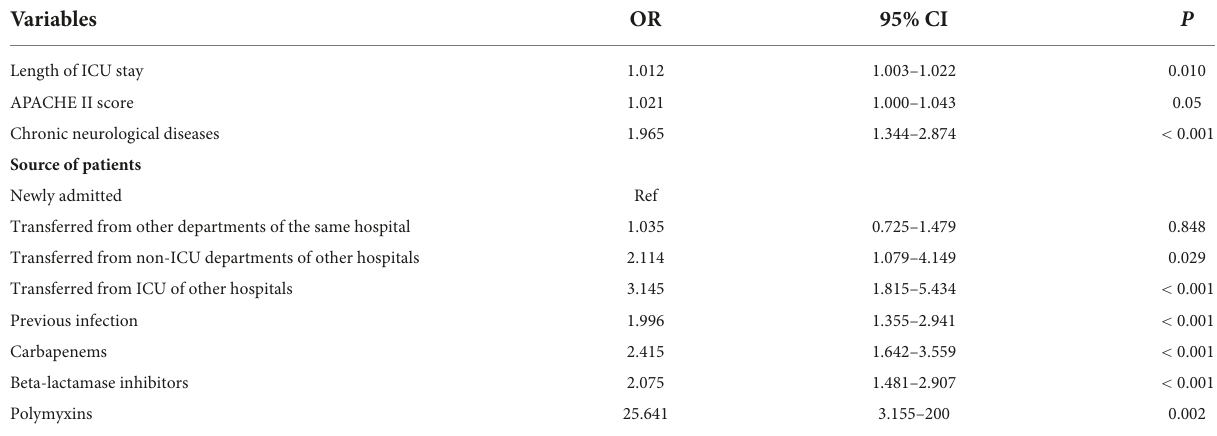
TABLE 5 Factors independently associated with CRE positive.